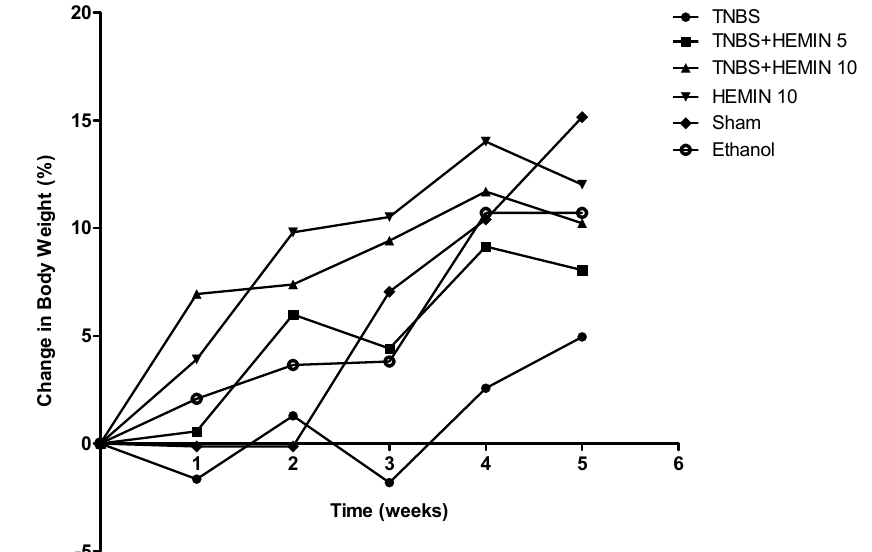
Figure 1. Change in body weight during hemin treatment in the IBD.